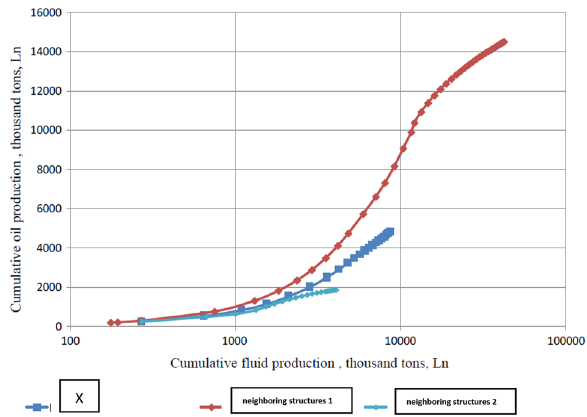
Fig. 15 Driving‑out curves of blocks of neighboring structures field